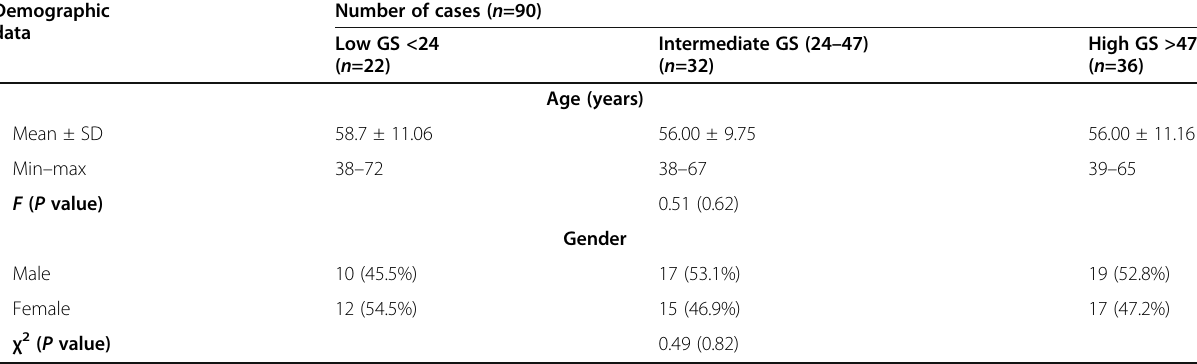
Table 1 Comparison between the studied patients as regard age and sex Demographic